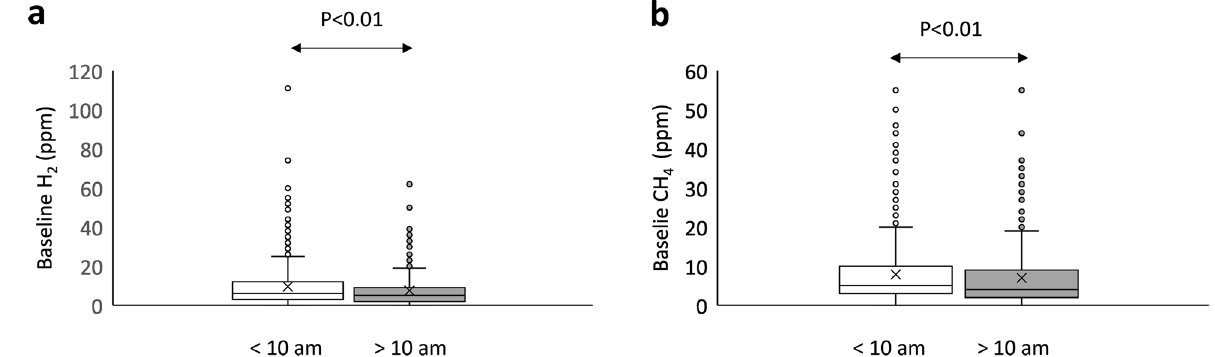
Figure 1. Baseline levels of H 2 ( a ) and CH 4 ( b ) according to sampling hour. Baseline levels are represented in Box-Whisker